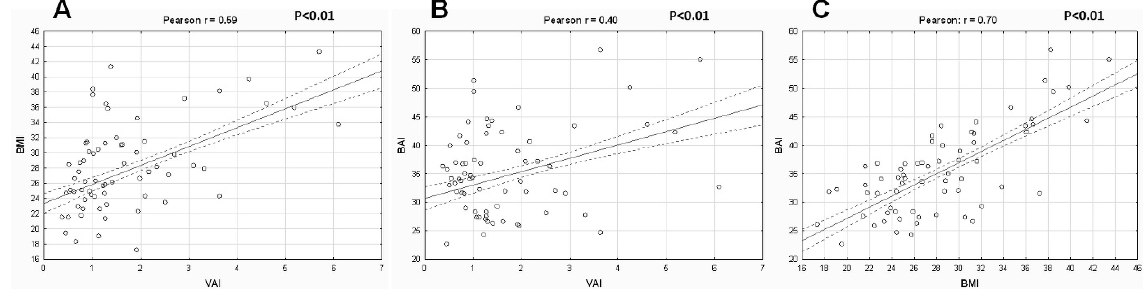
Figure 1. The correlation between (A) visceral adiposity index (VAI), (B) body adiposity index (BAI), and (C) body-mass index (BMI).